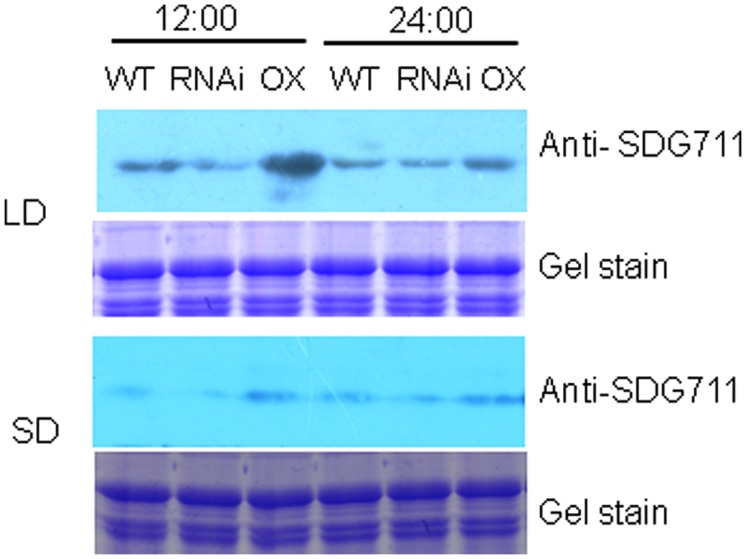
SDG711 protein accumulation in LD - and SD- grown WT, SDG711 RNAi and OX mature leaves of plants from 3 T3 lines harvested at noon (12:00) and mid night (24:00). Protein extracts were resolved by SDS-PAGE and Coomassie stained before Western blotting with anti-SDG711.